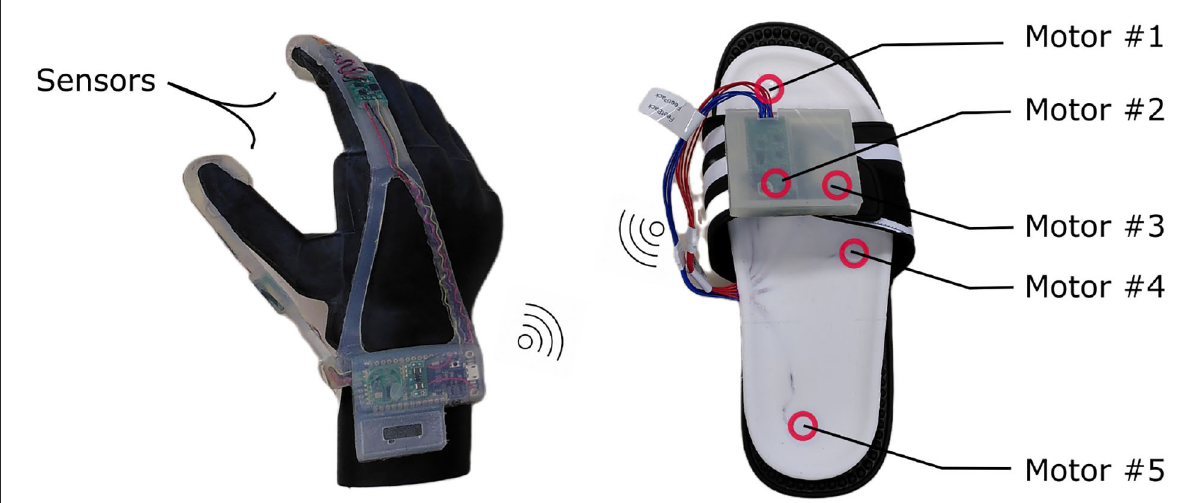
FIGURE1 FeetBack glove and insole. The glove senses the pressure on the fingertips of the index finger and the thumb. The higher force at either finger is defined to represent the grip force and is sent wirelessly to the insole. Depending on the force one of the five embedded coin vibration motors starts vibrating. The lower the force, the lower the number of the running motor (or no motor at all when the force is below a minimal threshold). The distribution of the motors was chosen accordingly to the distribution of fast adapting mechanoreceptors on the sole of the